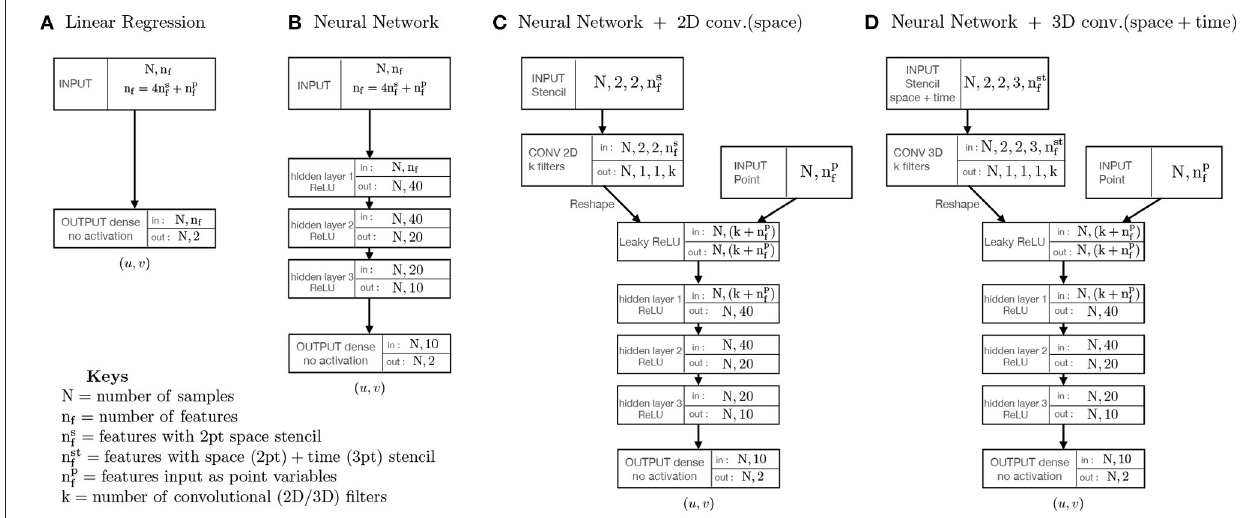
FIGURE 1 | (A–D) Schematic of the four different types of statistical models used in the study. All models shown were implemented using keras tensorflow (Chollet, 2015 ) and we use Mean absolute error (MAE) as the loss function and the Adam optimizer (Kingma and Ba, 2017) with default parameters and learning rates.